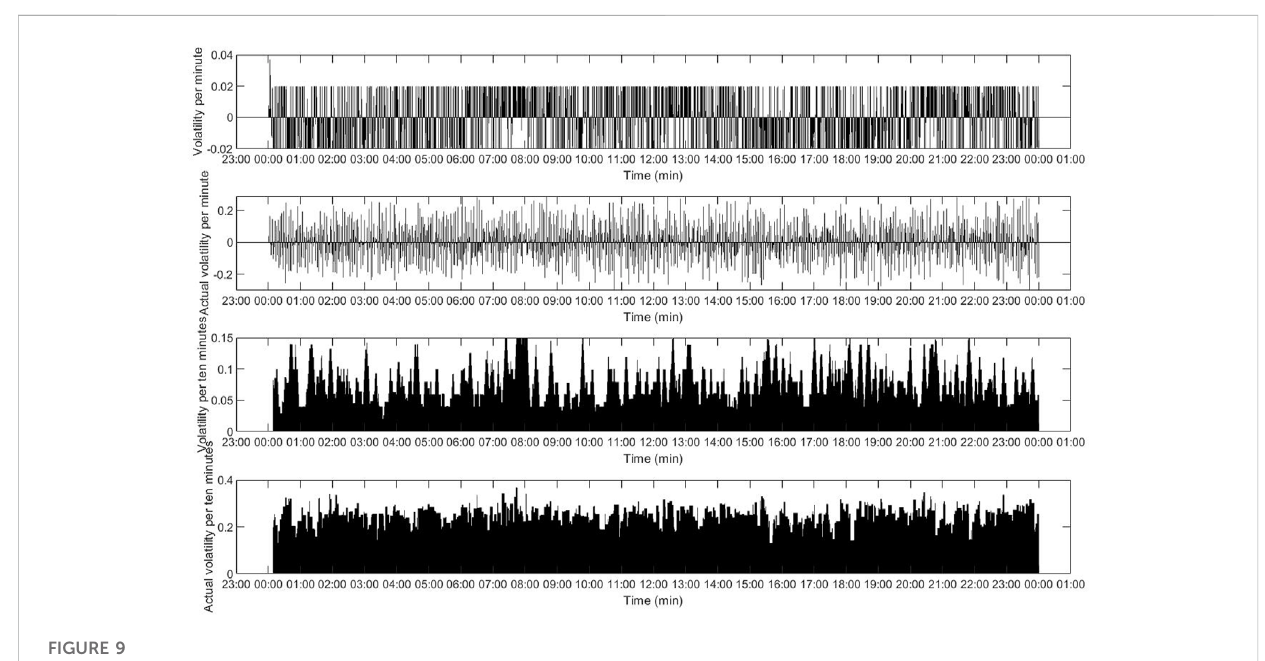
FIGURE 9 Volatility comparison chart.